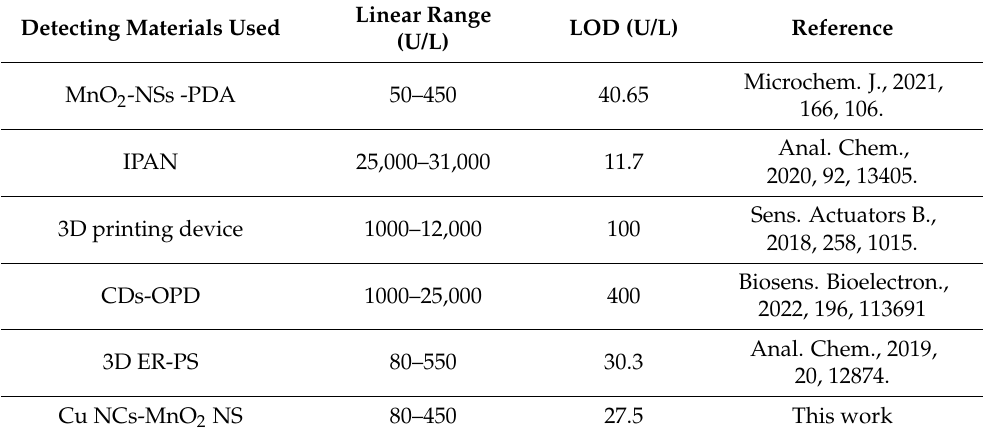
Comparison of the detection performances of our assay for BChE with recently reported